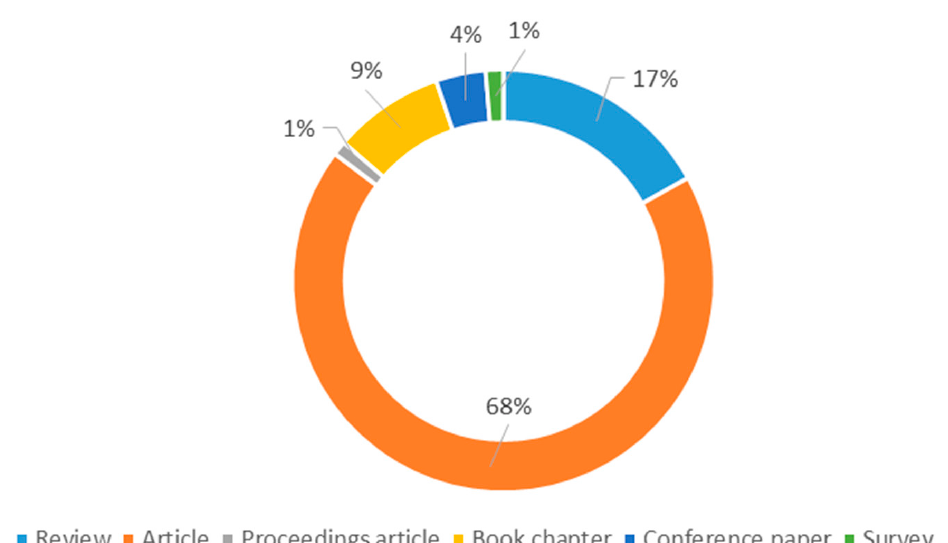
Figure 2. Paper distribution.